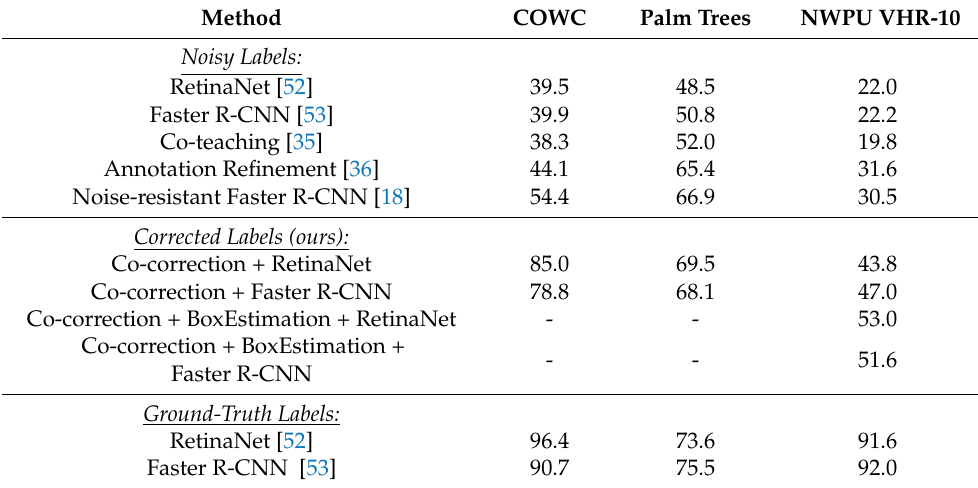
Table 2. mAP scores (in percent) for different object detection methods and datasets at test time. Results in the first, second, and third section were obtained when training on noisy, our refined, and clean ground-truth annotations, respectively. Scores for ground-truth labels serve as an upper bound for the models in the first two sections.